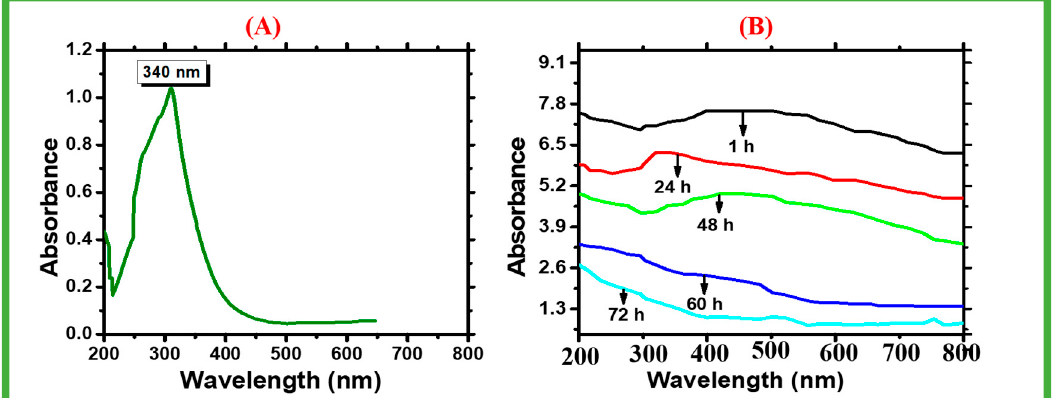
Figure 1. UV-vis spectra analysis of biosynthesized zinc oxide NPs. ( A ) UV-vis spectra, and ( B ) sta- bility of green-synthesized zinc oxide NPs. bility of green-synthesized zinc oxide